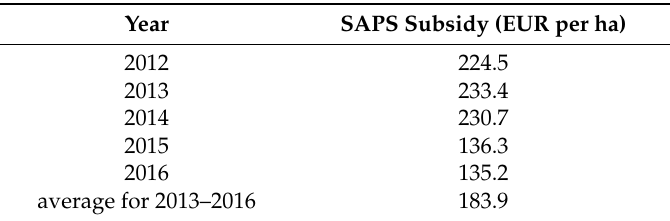
(SAPS: Single Area Payment